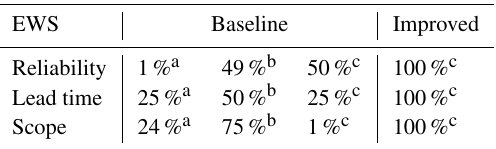
Table 1. Early warning baseline and improved scenarios. The 1% in the baseline is forced to avoid having a non-observable state in the vulnerability BN. EWS Baseline